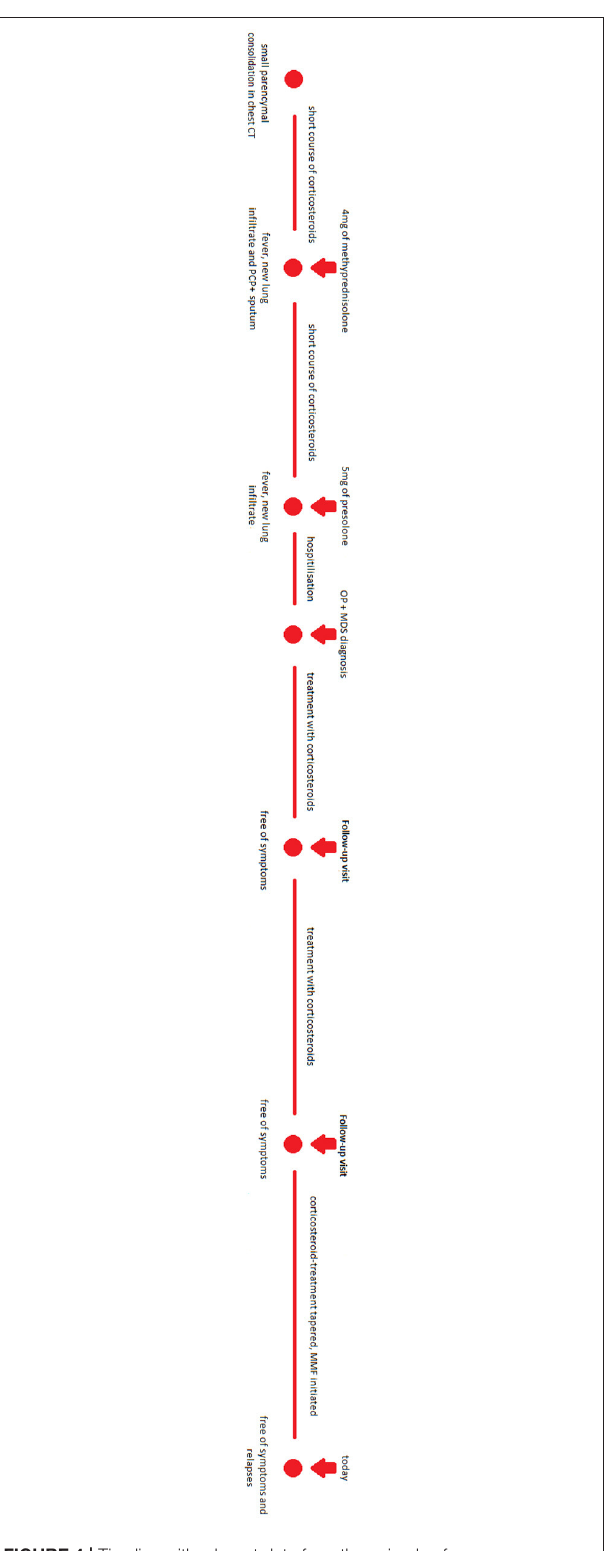
FIGURE 4 | Timeline with relevant data from the episode of